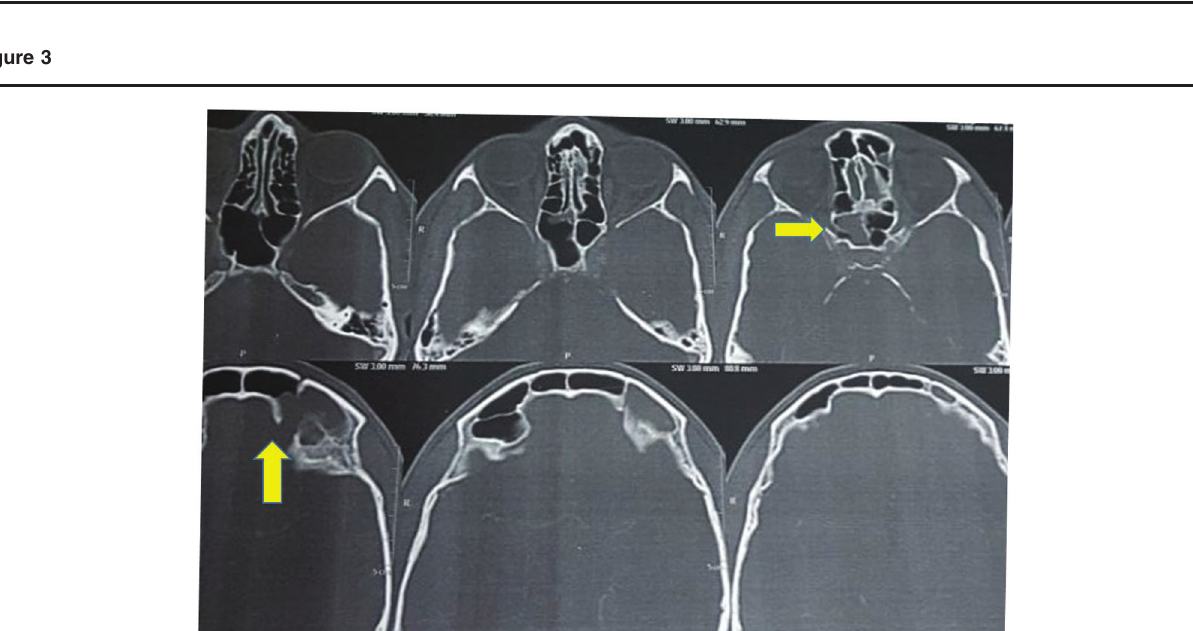
(a) Dry skull model. Right frontal in situ mini osteoplastic flap (blue star) with horizontal limb (white arrow), three ports (green, black and yellow arrows). Left frontal sinus open showing septum a supraorbital cell (blue arrow). (b) Same dry skull model. Right frontal multiportal approach with two instruments (right curved suction tip and left 45 degrees angled Bleksely